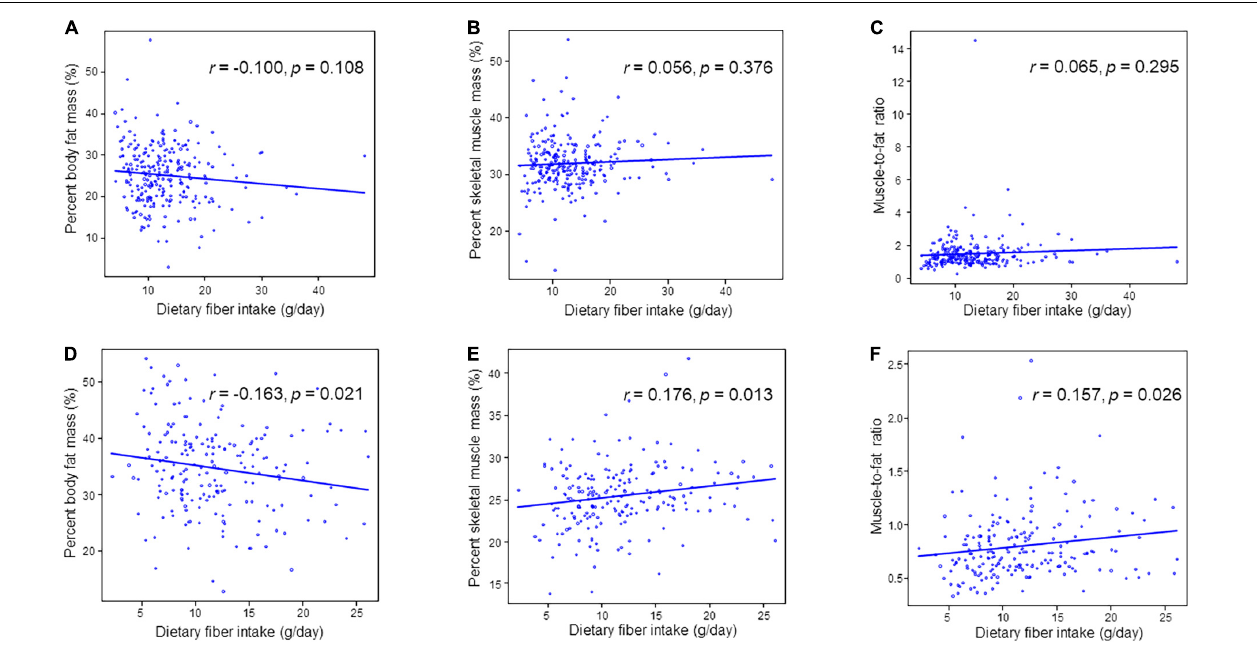
FIGURE 2 | Correlation between dietary fiber intake and percent skeletal muscle mass, percent body fat mass or muscle-to-fat ratio. (A) Percent body fat mass in men. (B) Percent skeletal muscle mass in men. (C) Muscle-to-fat ratio in men. (D) Percent body fat mass in women. (E) Percent skeletal muscle mass in women. (F) Muscle-to-fat ratio in